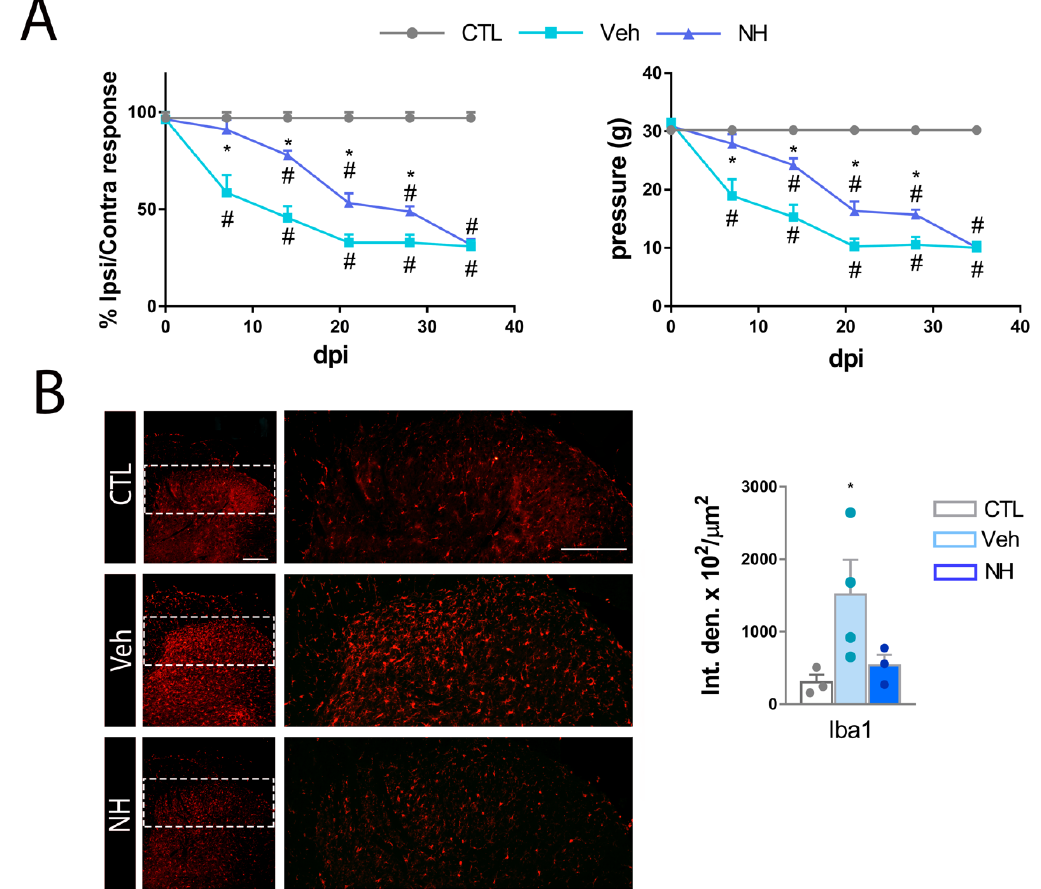
Figure 4. NeuroHeal reduces mechanical allodynia after SNI. ( A ) Changes in mechanical sensory thresholds recorded at the ipsilateral side of the right hindlimb from Control, Vehicle (Veh), or 0.2× NeuroHeal (NH) dose at different dpi post SNI ( n = 5 CTL, 8 for other groups, ANOVA, post hoc Bonferroni, * p < 0.05 vs. Veh, # p < 0.05 vs. CTL). ( B ) Top, representative fluorescence microphotographs of the ipsilateral dorsal horns of the spinal cord from CTL or SNI injured animals immunolabeled against Iba1. Bottom, bar graph of the average of Iba1 immunoreactivity intensities within dorsal horn for different experimental groups at 35 dpi ( n = 3–4 biological replicates, ANOVA, post hoc Bonferroni, * p < 0.05 vs. CTL, Scale bar = 200 μm).